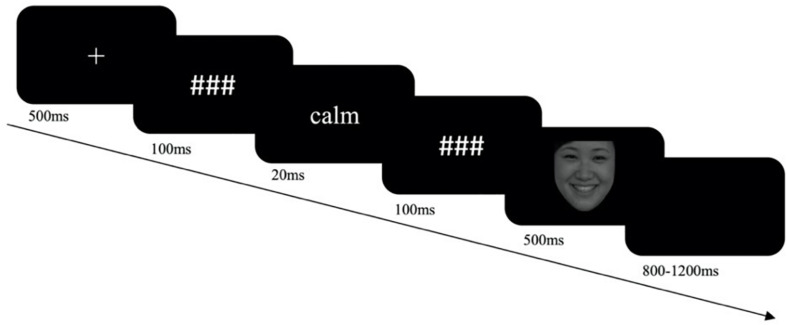
The procedure of a single trial of the experiment. The facial picture in the procedure is from the Chinese Facial Affective Picture System (Gong et al., 2011).